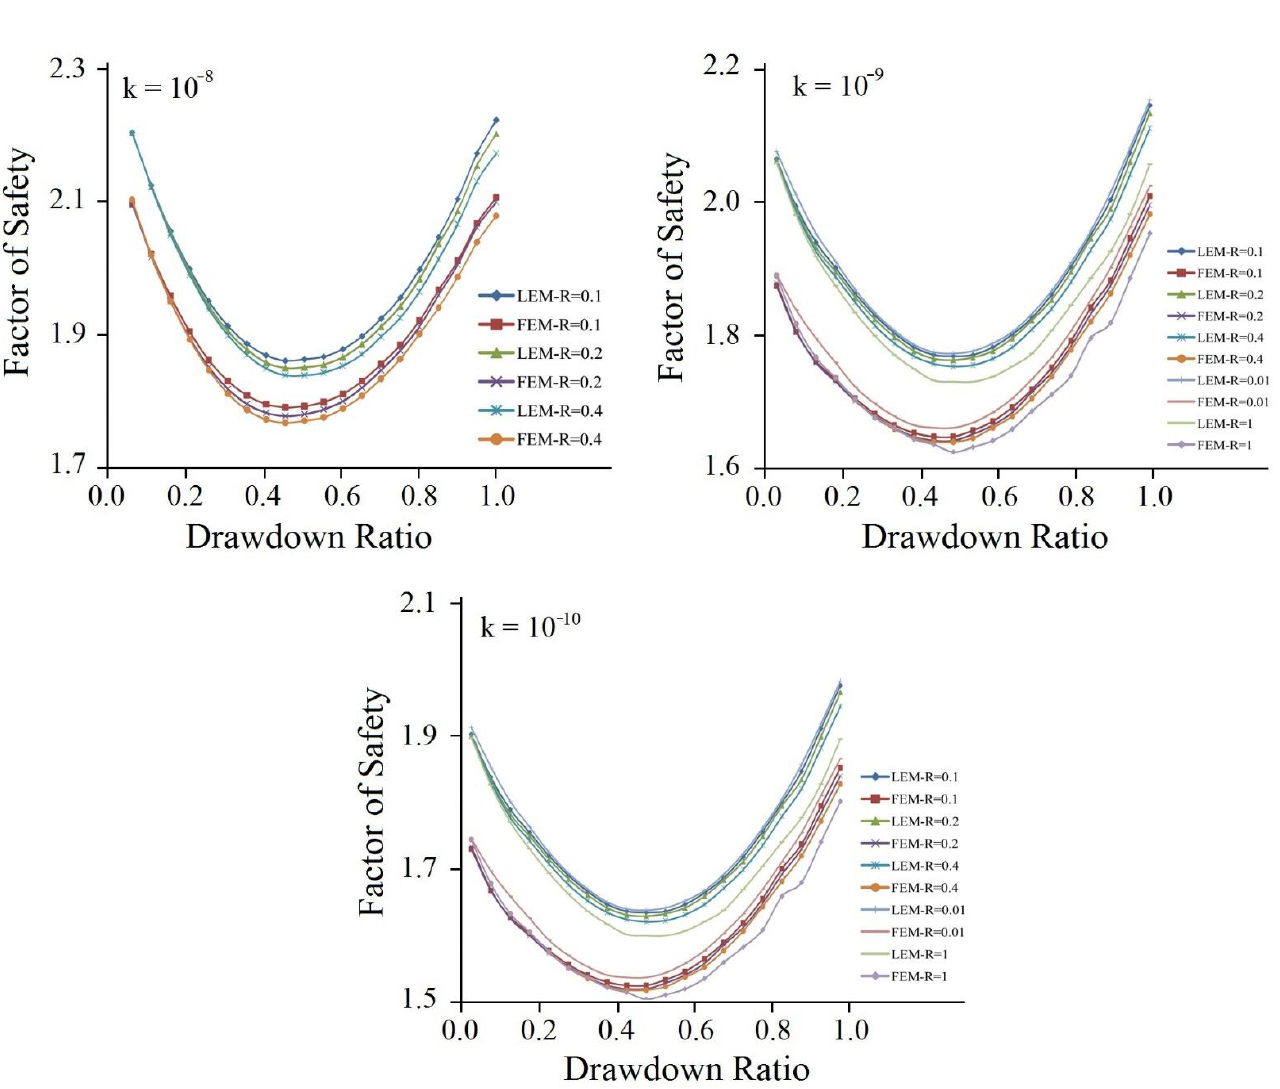
Figure 9. The F.S vs. drawdown ratio in the shallow sliding surface based on LEM/FEM models.